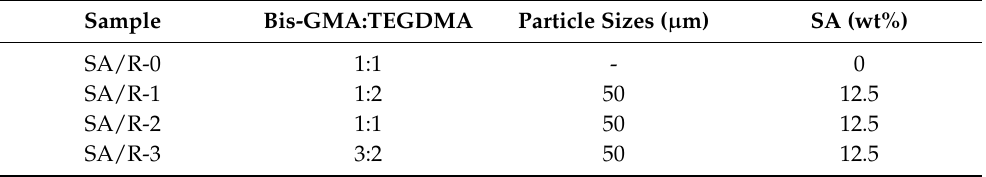
Table 3. Experimental parameters of silica aerogel/resin